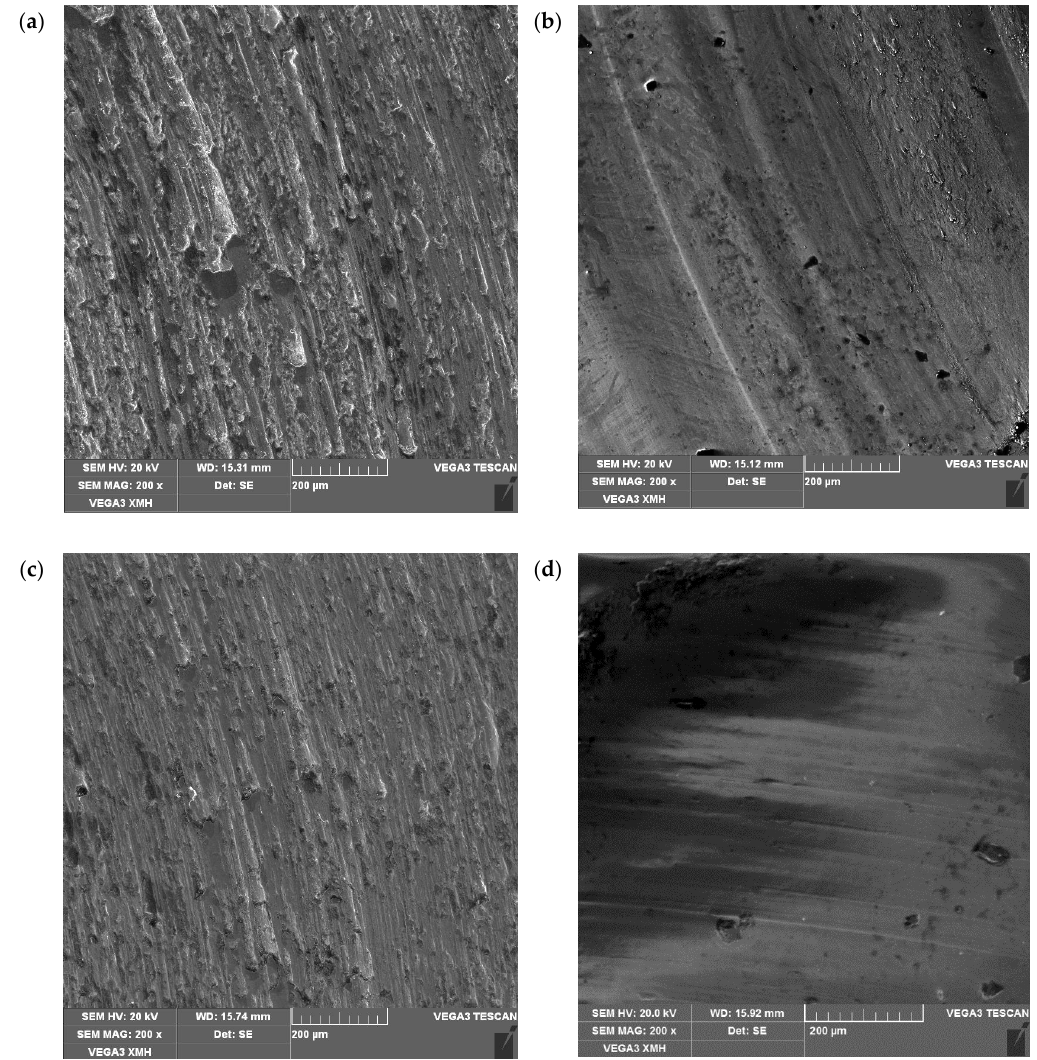
Figure 8. Worn surface of S4 disc ( a , c ) and co-acting ball ( b , d ) at the sliding speed of v = 0.16 m/s ( a , b ) and v = 0.64 m/s ( c , d ).